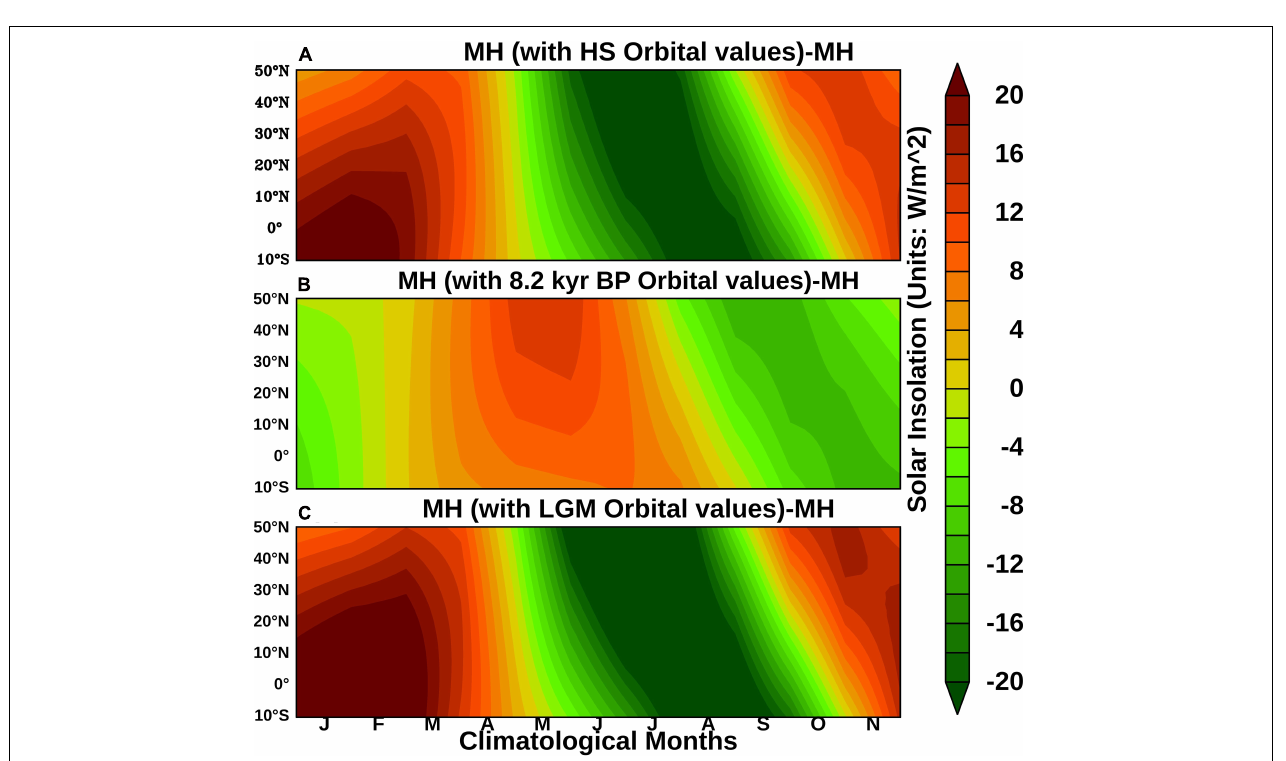
FIGURE 7 | Simulated insolation difference (W/m 2 ) between Mid-Holocene and HS (present-day). Averaged over all the longitudes (0 ◦ E to 360 ◦ E).